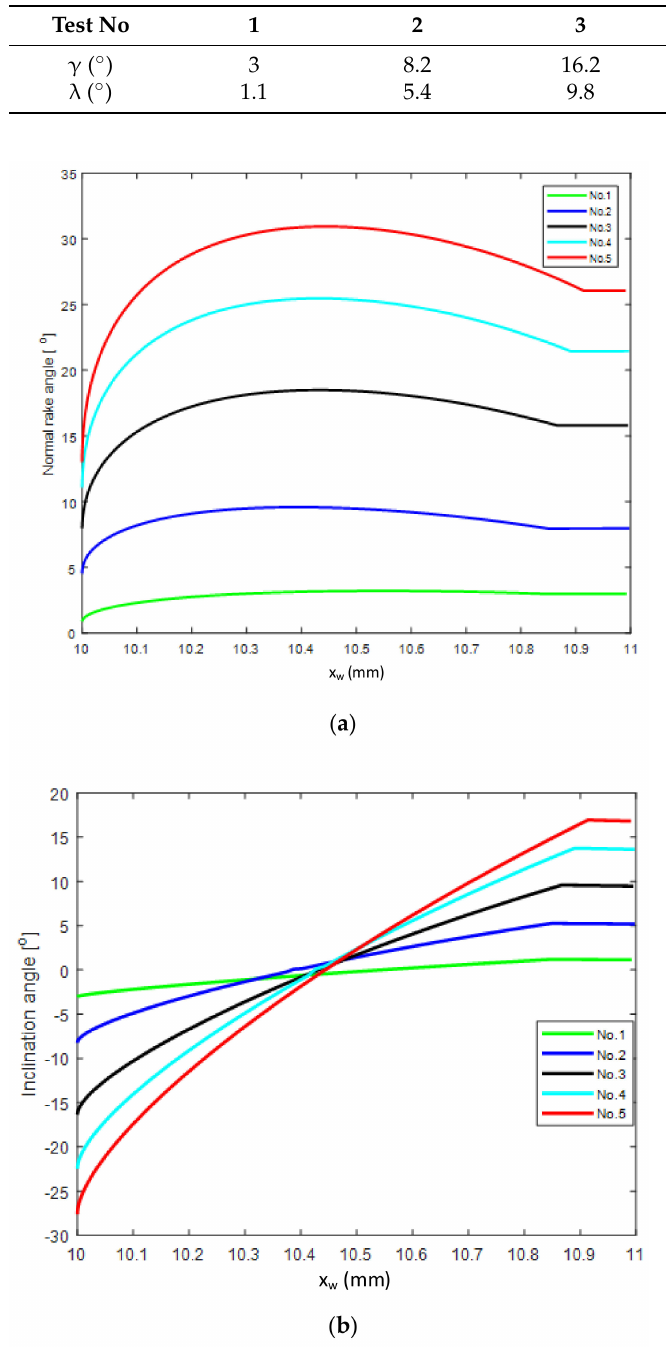
Table 2. Normal rake angle and inclination angle in